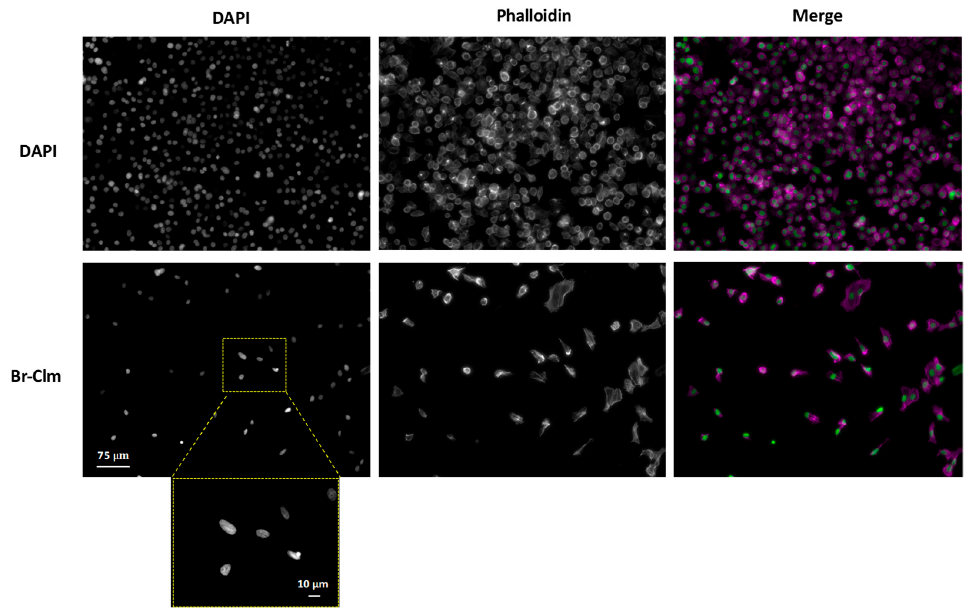
Figure 5. Morphological assessment of the effect of Br ‐ Clm (100 μ M) upon AGS cells after 24 h of incubation. Cell morphology was evaluated using phalloidin (cytoplasmic traits) and DAPI (chromatin status). Objective: 20×/40× (insert).